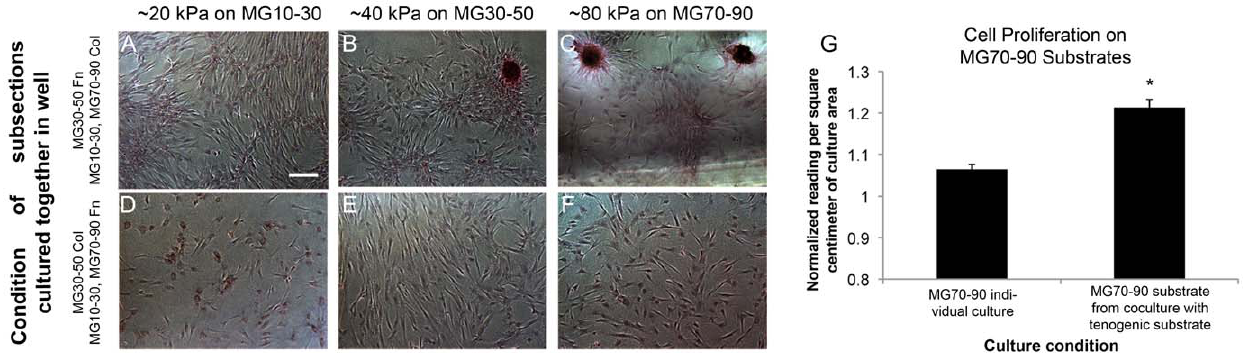
Figure 6. Culture of soft, intermediate, and stiff subsections of the gradient within the same well. (A–C) Osteogenic behavior was seen on the MG30–50 fibronectin substrate as well as the MG70–90 collagen substrate. (D–F) Morphologically the cells appeared similar to analogous subregions of MG10–90 collagen substrate studies, however osteogenic plaques were not visualized on MG70–90 fibronectin substrates. Scale bar represents 100 m m. (G) An increase in cell proliferation was observed on the osteogenic MG70–90 substrate (collagen functionalized) when co- cultured with a tenogenic substrate compared to the osteogenic substrate alone. * statistical difference (p , 0.05) between the two conditions.